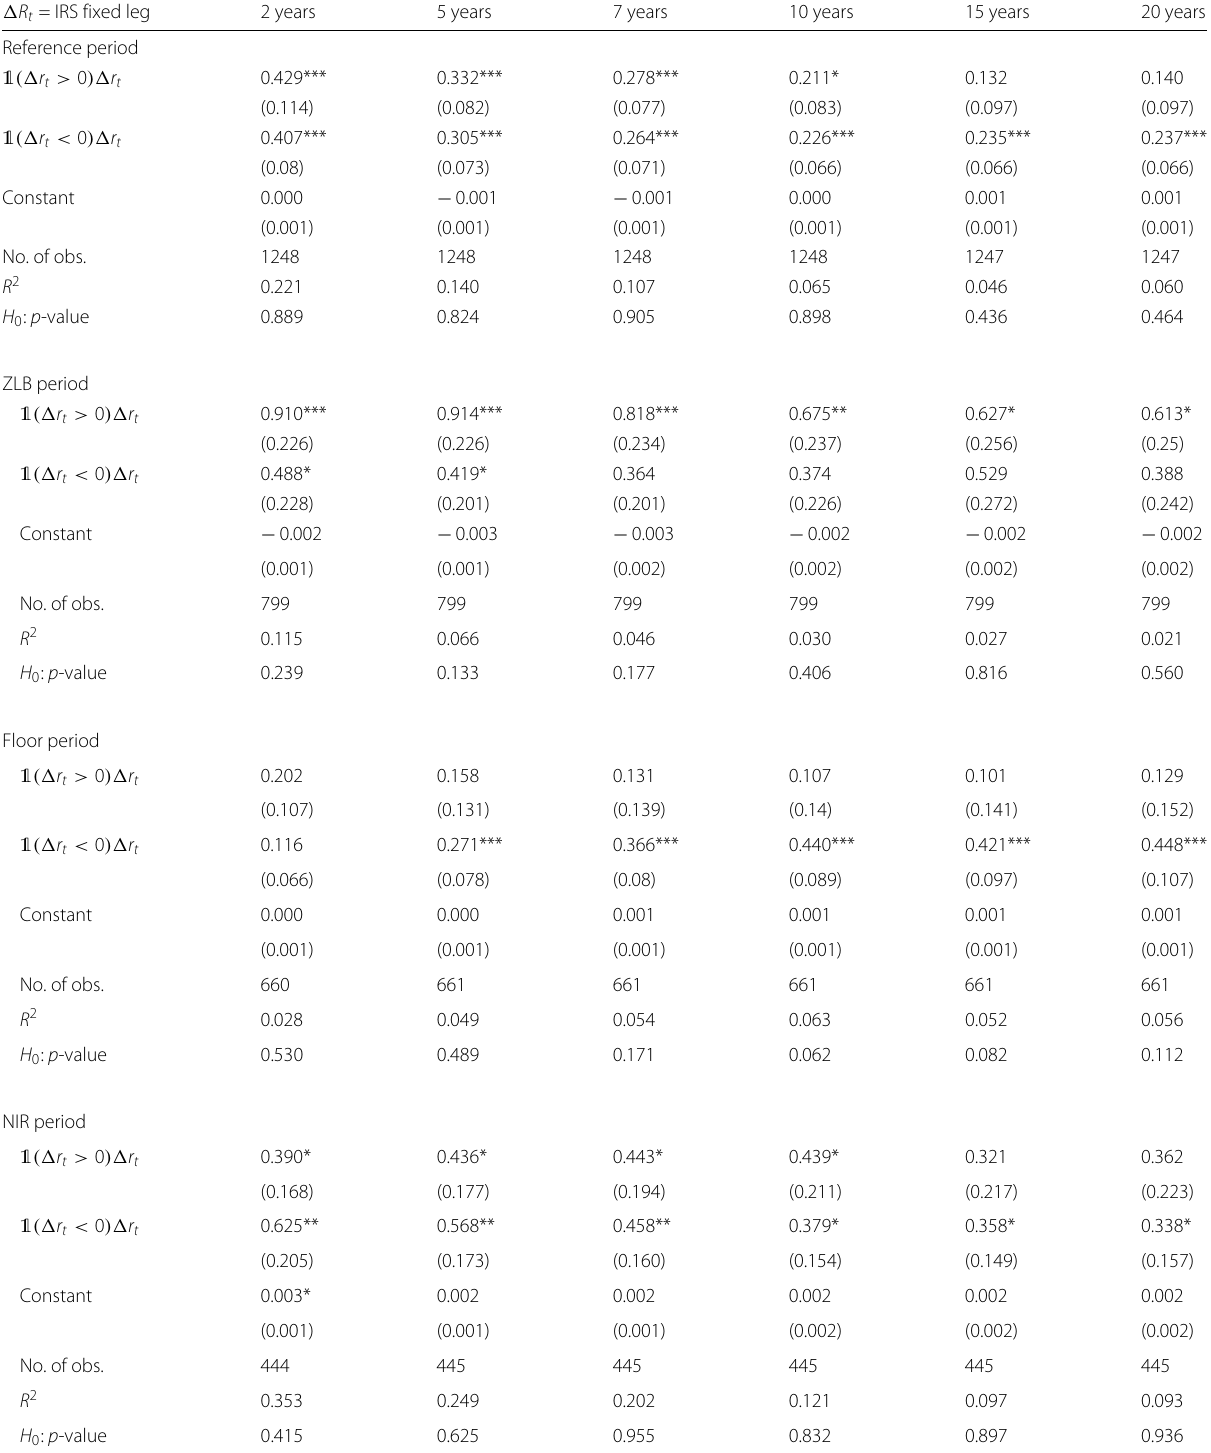
Table 4 Robustness: IRS rates and additional control